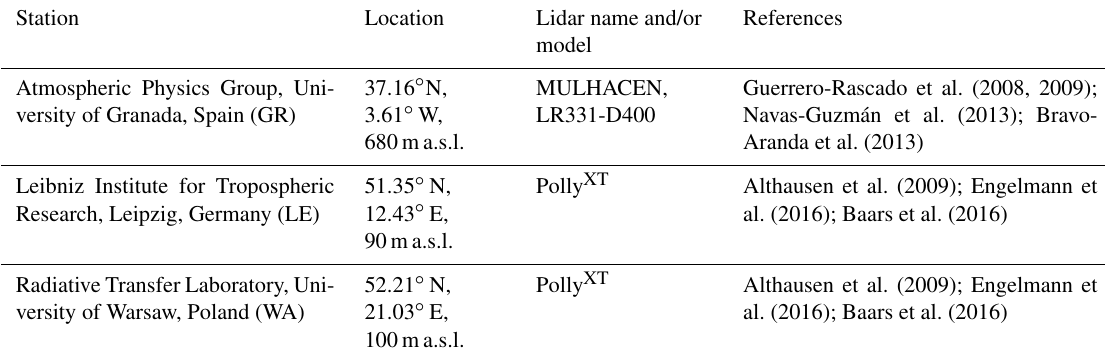
Table 1. Geographical location of the selected EARLINET stations and lidar system providing data for this study.